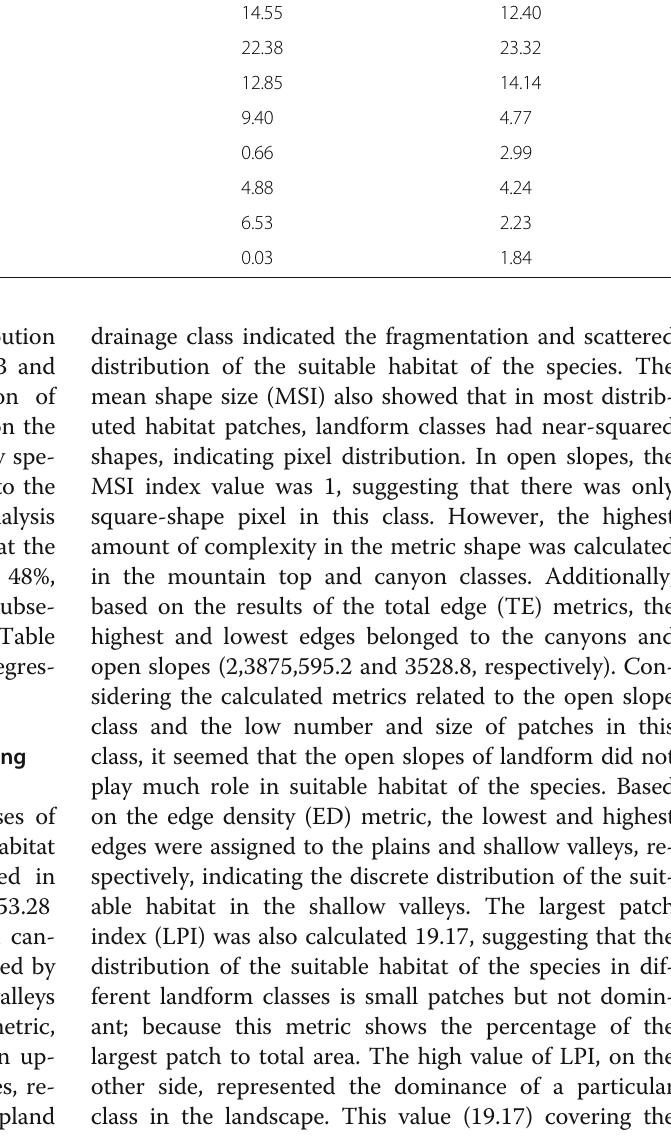
Table 5 Evaluation functions of the random forest regression performance in analyzing the importance of variables